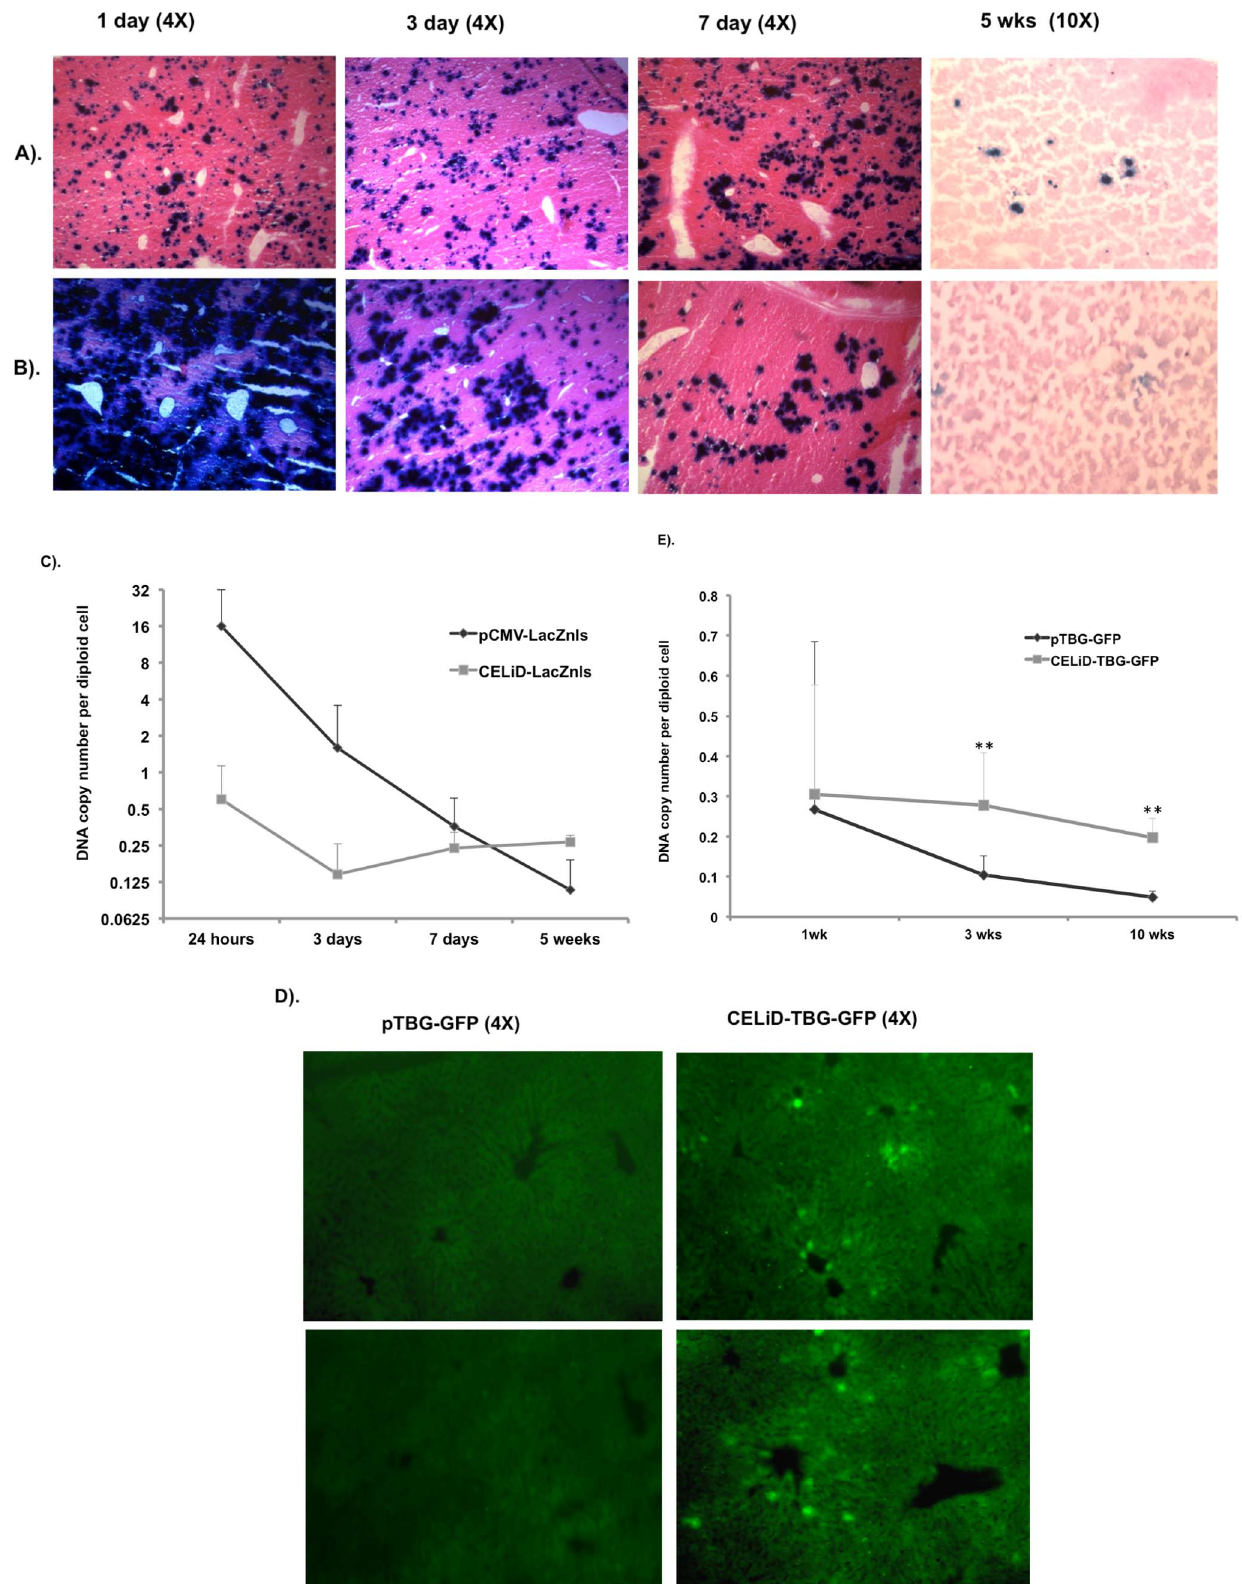
Figure 8. Invivo gene expression and DNA copy number per diploid cell following tail vein injection of (A) CELiD-LacZnls or (B) Plasmid-LacZnls (pCMV-LacZnls). 1 m g of CELiD DNA or 10 m g of the circular plasmid DNA was administrated by hydrodynamic tail vein injection. Transfected livers were harvested and processed at days 1, 3, and 7, as well as 5 weeks post-injection. Histological samples were sectioned and PLOS ONE |